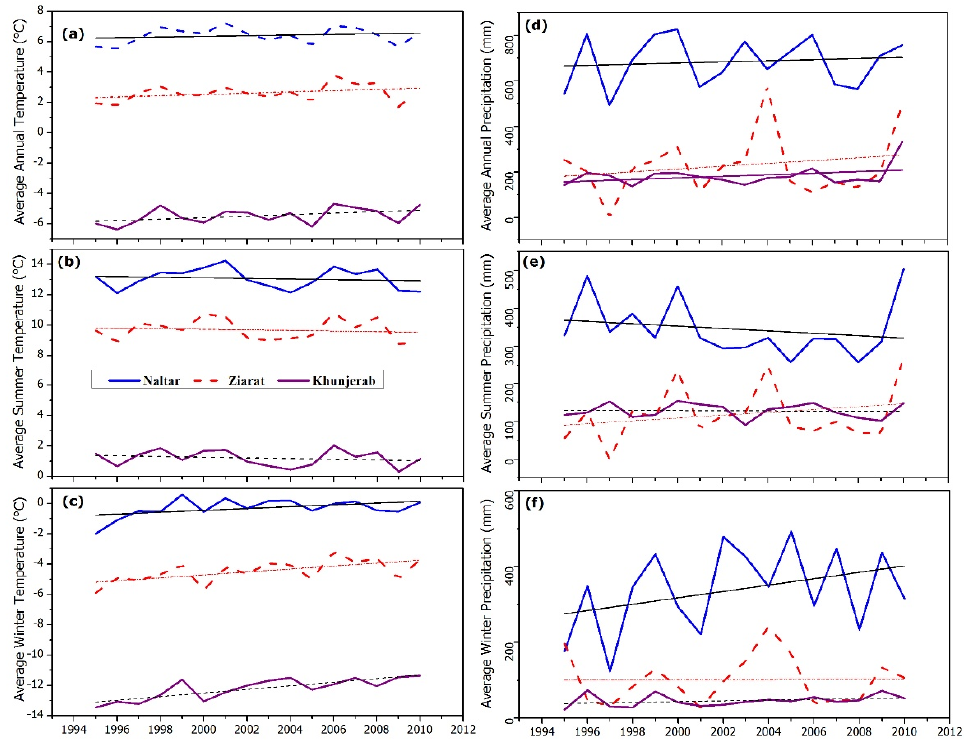
Figure 6. The left side shows annual, summer, and winter temperatures from top to bottom ( a – c ), whereas the right side shows respective precipitation having the same pattern ( d – f ) during the 1995–2010 period from all three stations in the Hunza Basin. The blue solid line represents recordings at Naltar, the red dashed line at Ziarat, and the purple solid line at Khunjerab.